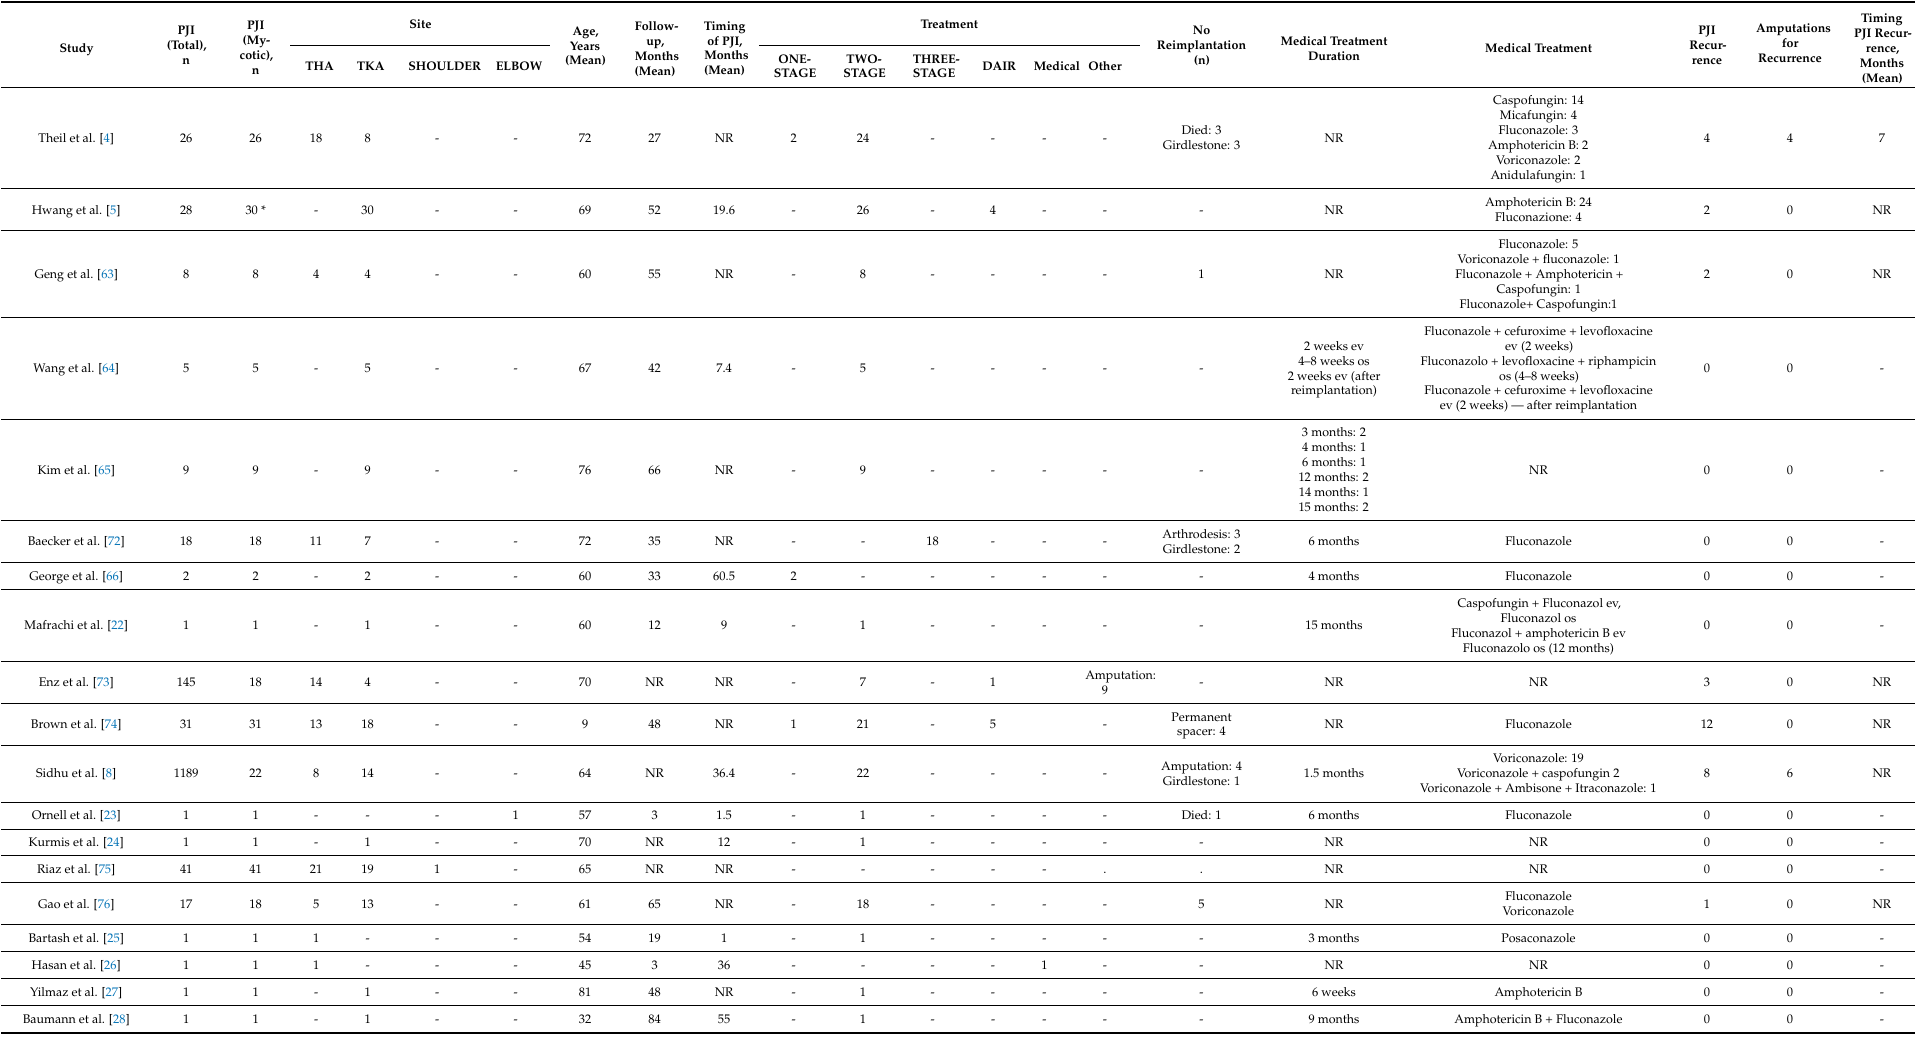
Table 1. Review of the